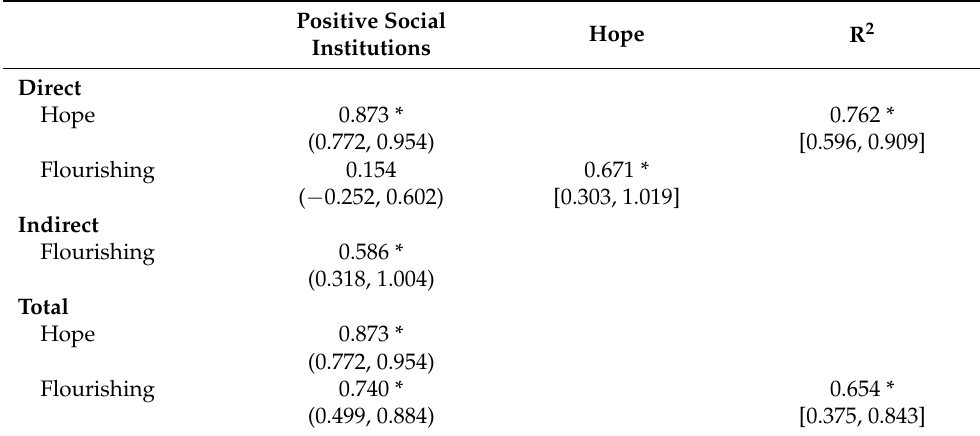
Table 3. Bootstrapped standardized effect sizes: